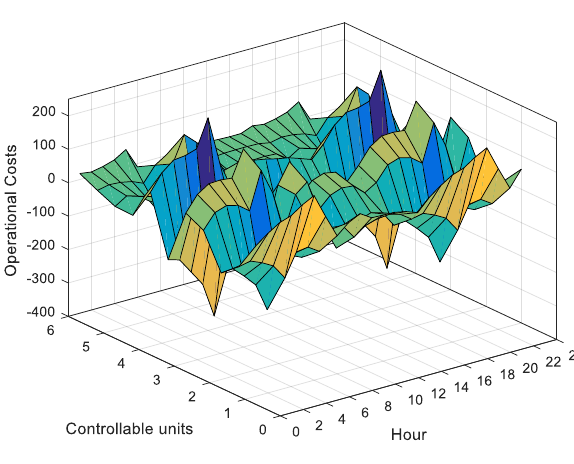
F (t) verses the number of Figure 8. Variation in d controllable units and time in grid-connected